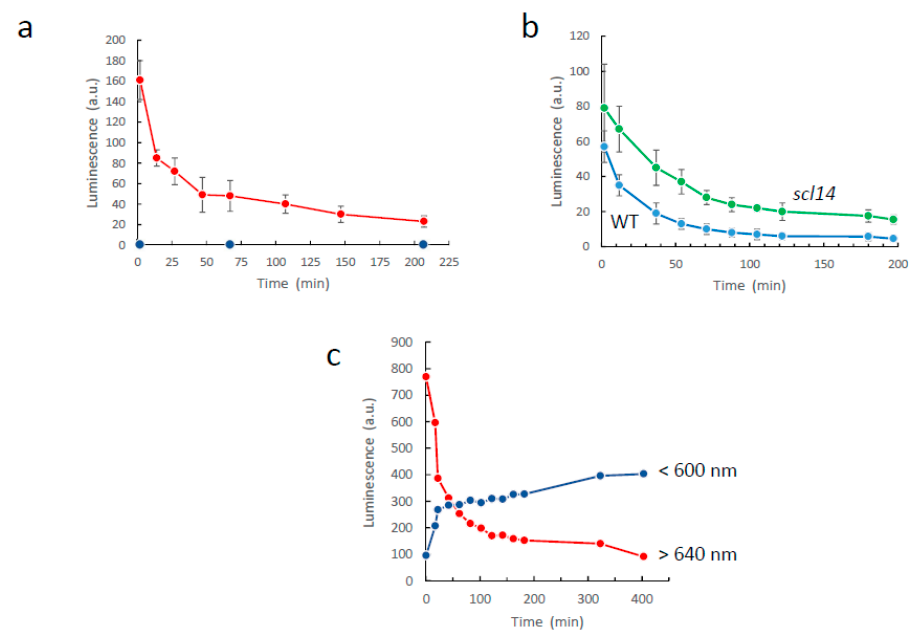
Figure 11. Stability of lipid peroxidation-related SCL. ( a ) Time course of the change in endogenous chemiluminescence in wounded Arabidopsis leaves: in red, total emission; in blue, emission at wavelengths <600 nm. ( b ) Comparison of the time dependence of SCL from wounded WT and scl14 leaves. ( c ) Time course of the changes in luminescence emission from oxidized lipids in the blue-green (<600 nm) and red/far-red (>640 nm) light domains. Linolenic acid was oxidized by soybean LOX as in Figure 3e–g. The blue-green and (far-)red signals were measured simultaneously by placing a LG640 filter or a LS600 filter above the lipid solutions in the black box of the CCD camera installation.